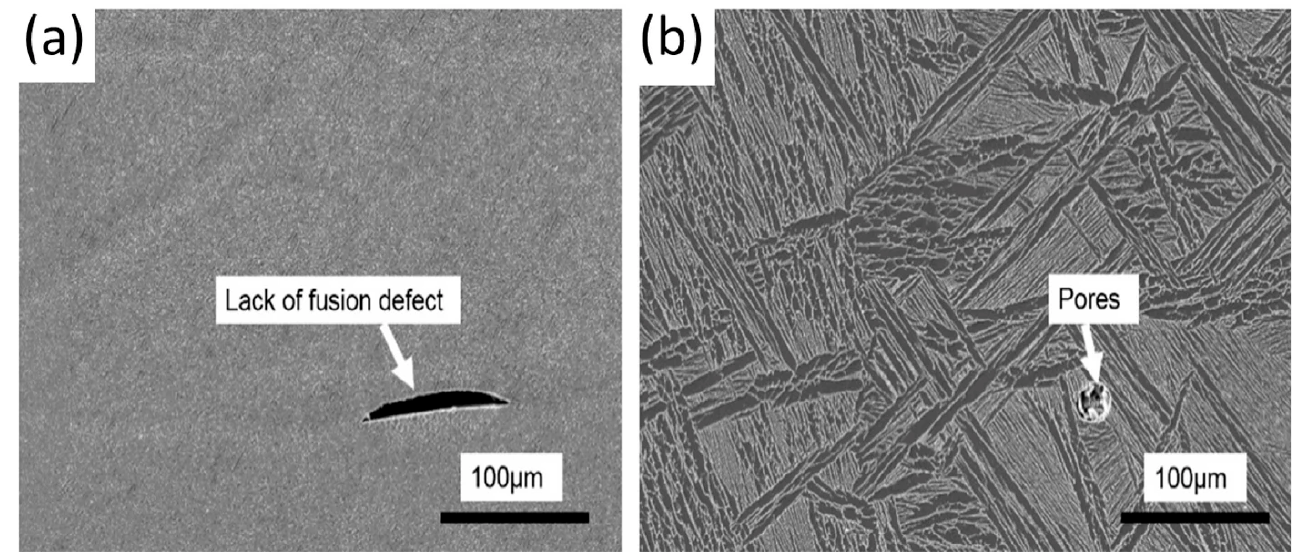
Figure 6. Directional energy forming Ti-6Al-2Zr-2Sn-3Mo-1Cr-2Nb forming parts defects ( a ) un- melted powder ( b ) porosity. Reprinted with permission from Ref. [90]. Copyright 2021, copyright Liu Z, He B, Lyu T, Zou Y.